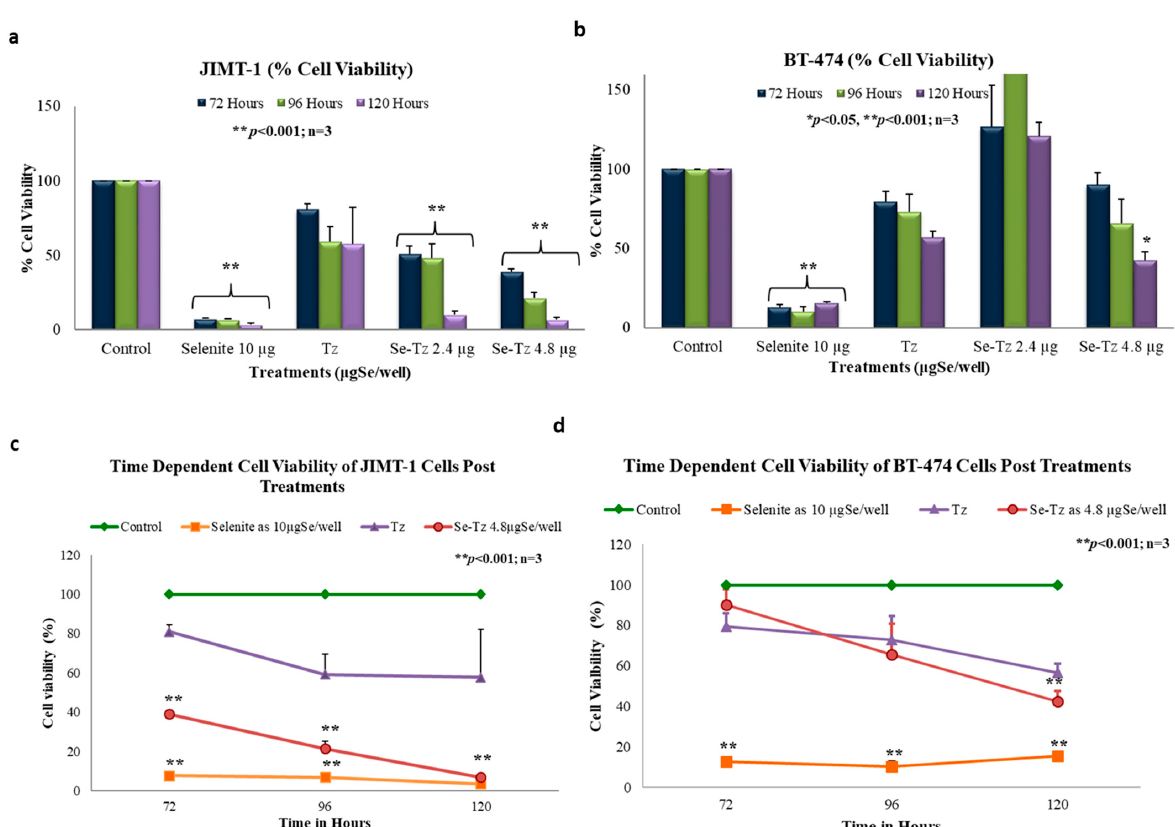
Figure 8. Cells were treated with Se-Tz at the concentrations of 2.4 and 4.8 µ gSe/well and Tz cells were treated with an equal mab protein concentration. Selenite was used as a redox toxic positive control at a concentration of 10 µ gSe/well